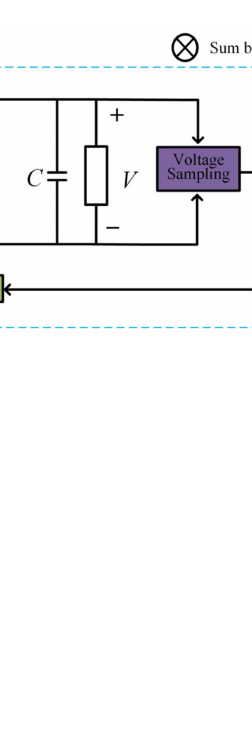
Figure 3. CPLs’ voltage and current curve.